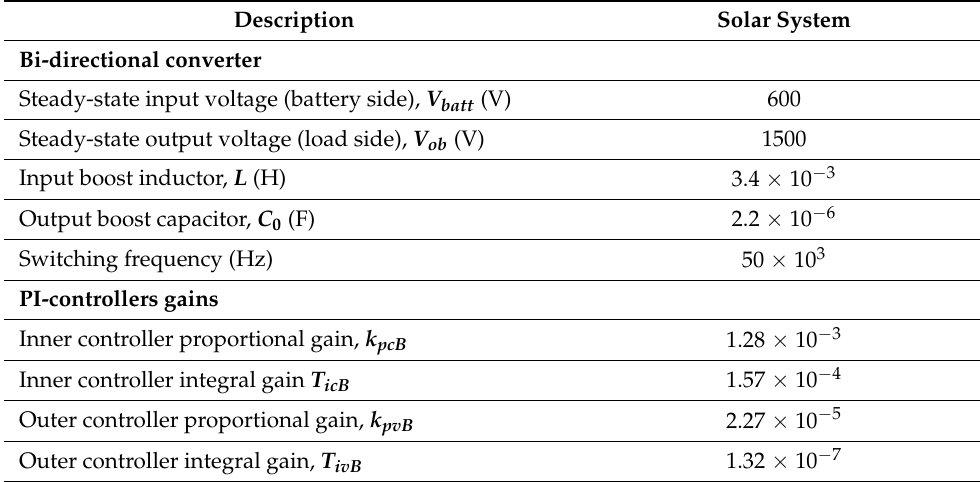
Table A3. Parameters list of a battery